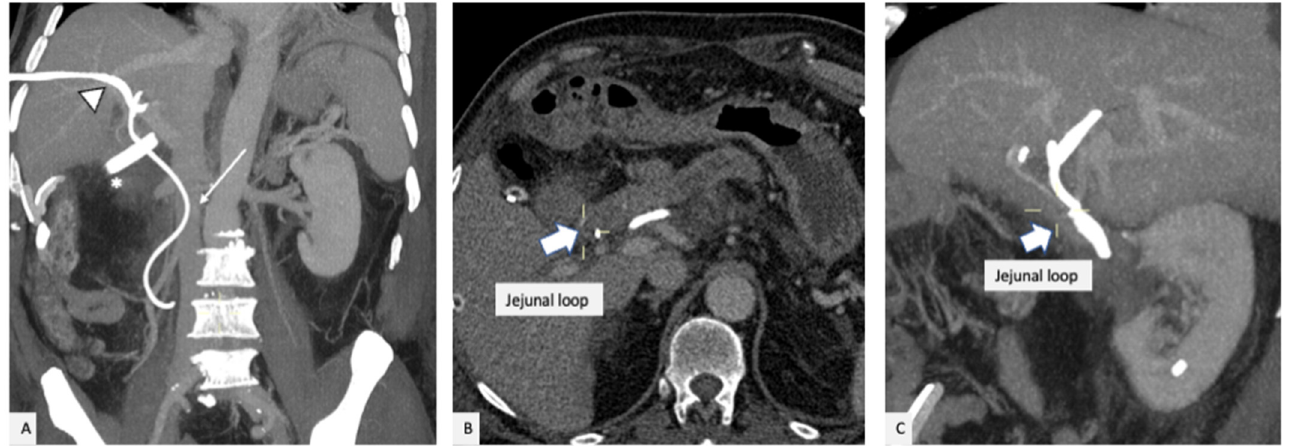
Figure 4. ( A ) coronal MIP reconstruction displaying the percutaneous drainage into the biliary tree (arrowhead) and the angiographic catheter (arrow) into the peritoneal cavity; surgical drainage at the hepatic hilum (*). ( B , C ) axial and sagittal images confirming that the anastomotic jejunal loop was located anteriorly to the angiographic catheter positioned into the biliary tree.